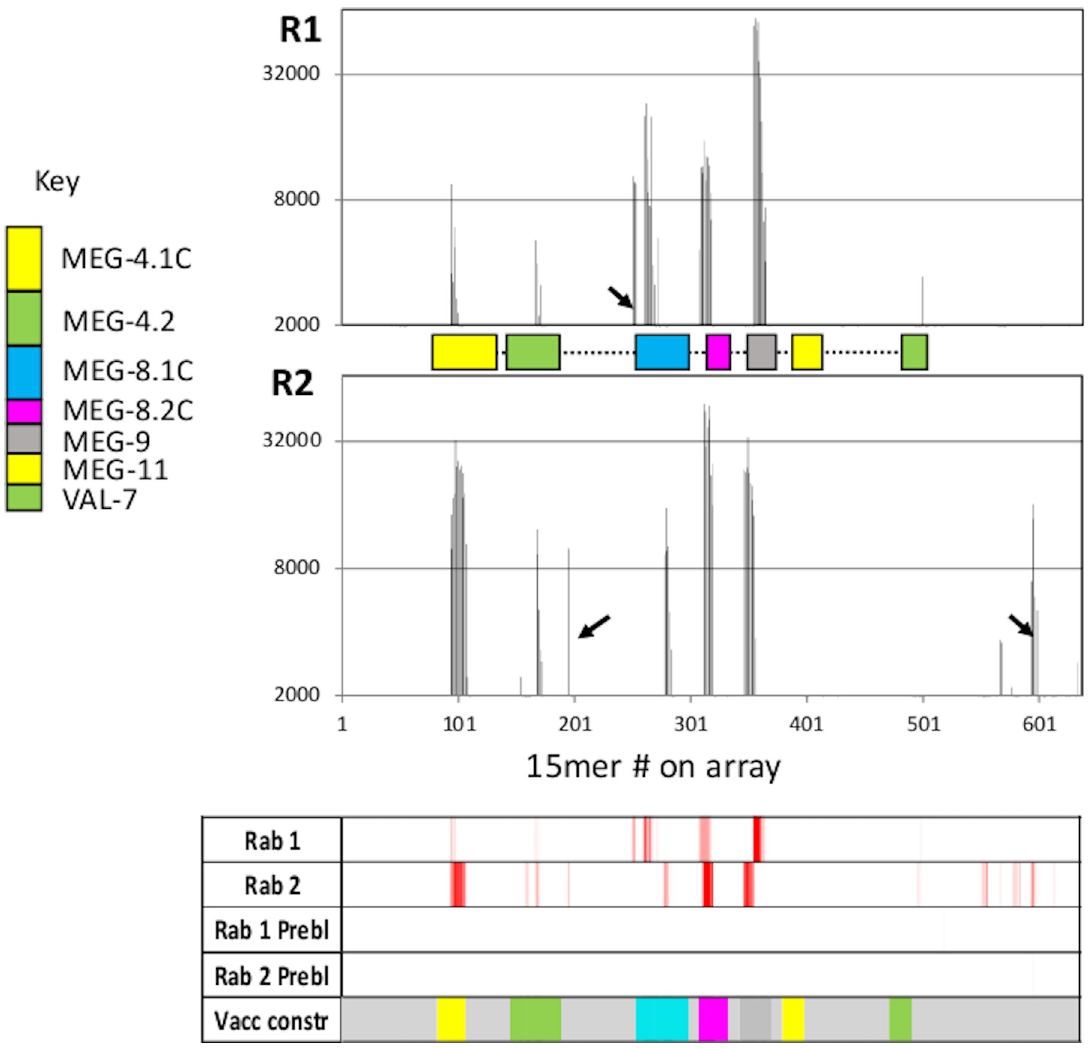
Fig 7. Reactivity of the recombinant protein comprising seven regions of the proteins represented on Array 1a. Linear plots and corresponding heatmap show that five of seven constituent peptides elicited a response in two outbred rabbits (MEG-11 was the notable exception). The primary antibody was reacted at a dilution of 1:1000; the intensity of response revealed by the PSA scores is much higher than after infection of rhesus macaques, rabbits or mice with S . japonicum